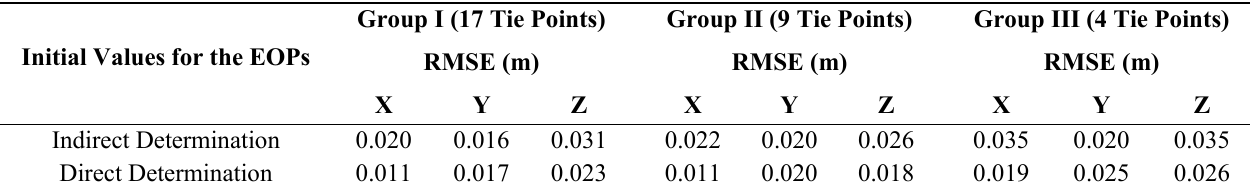
Table 4. RMSEs obtained for three quantities of tie points considering the resampled images.